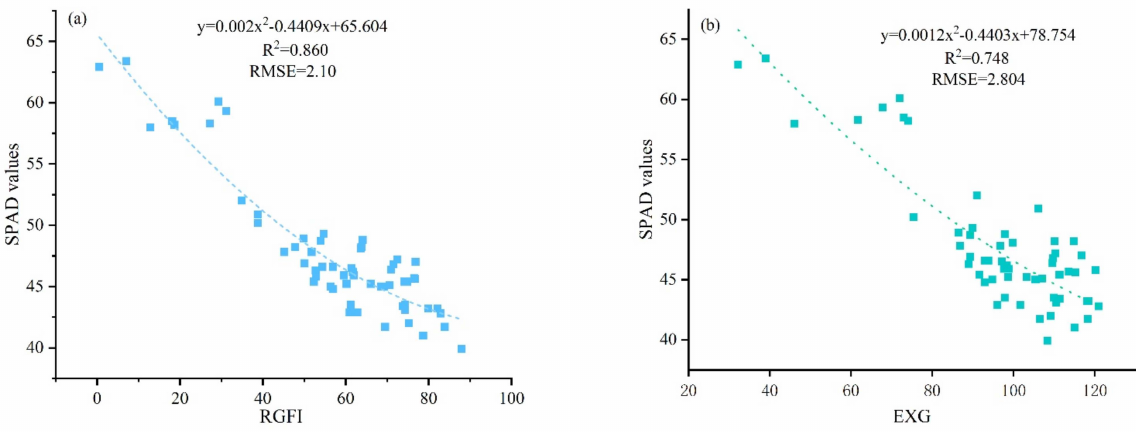
Figure 5. Fitting results of SPAD value using 2nd-order polynomial function at 4 g N pot − 1 . ( a ) Fitting results of RGFI; ( b ) Fitting results of EXG.